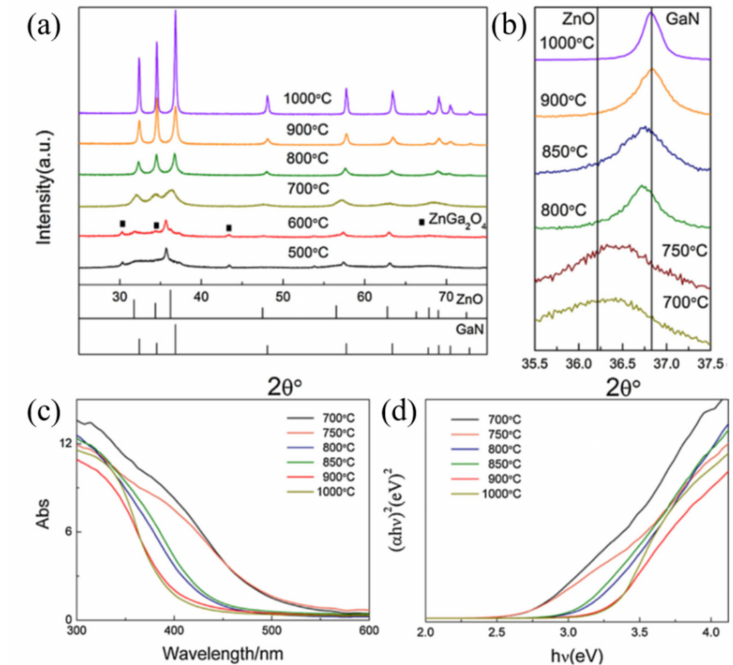
Figure 6. XRD patterns of samples calcined at different temperatures ( a , b ), UV–vis diffuse reflection spectra of the zinc-doped gallium oxynitride nanofibers calcined at different temperatures ( c ), and the corresponding plots of ( α hv ) 2 vs. photon energy ( hv ) ( d ). (Redrawn with the permission of Ref. [56]. Copyright 2017